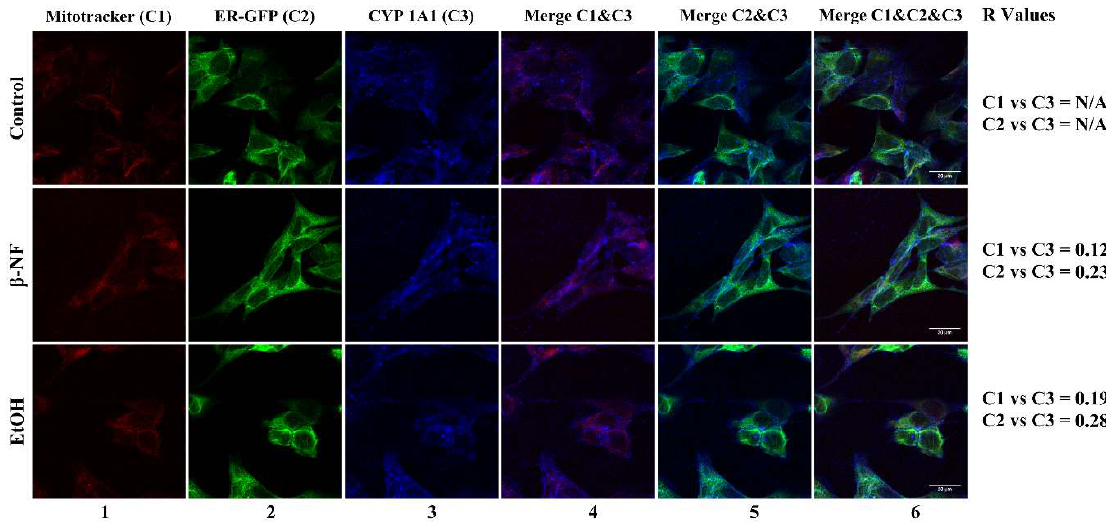
Figure 6. Immunostaining of CYP1A1 in SH-SY5Y cells after β-NF and EtOH treatment. Representative immunofluorescence images of each experimental condition. Column 1 represents mitochondrial stain (red), column 2 represents ER-Green Fluorescent Protein (GFP) stain (green), and column 3 reports the CYP1A1 staining (blue). Column 4 represents the merge between CYP1A1 and mitochondria channel, column 5 represents the merge between CYP1A1 and ER-GFP, and column 6 represents the merge of the three channels. R Values: Pearson’s correlation coefficient. N/A: Not determined. Scale bar: 20 µm.